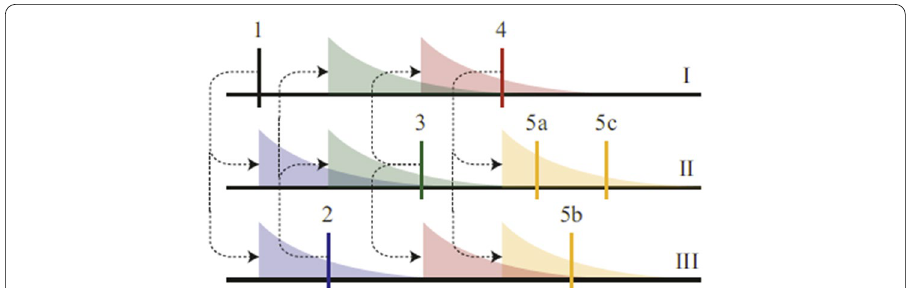
Fig. 14 An example of Hawkes process. Events from one process induce events on the other connected processes and hence cause a cascade of events. Further explanation in text. Picture taken from (Linderman and Adams